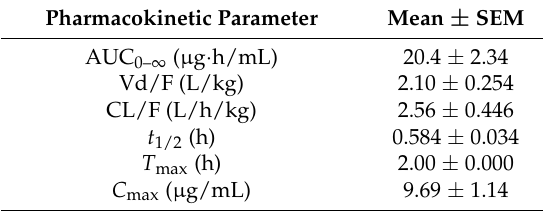
Figure 4. Glucosamine disposition in serum following oral administration of one Phycox ® soft chew containing 450 mg of glucosamine hydrochloride ( n = 4, mean ± SEM). Table 4. Pharmacokinetic parameters of glucosamine (450 mg) administered in one Phycox ® soft chew in the dog ( n =